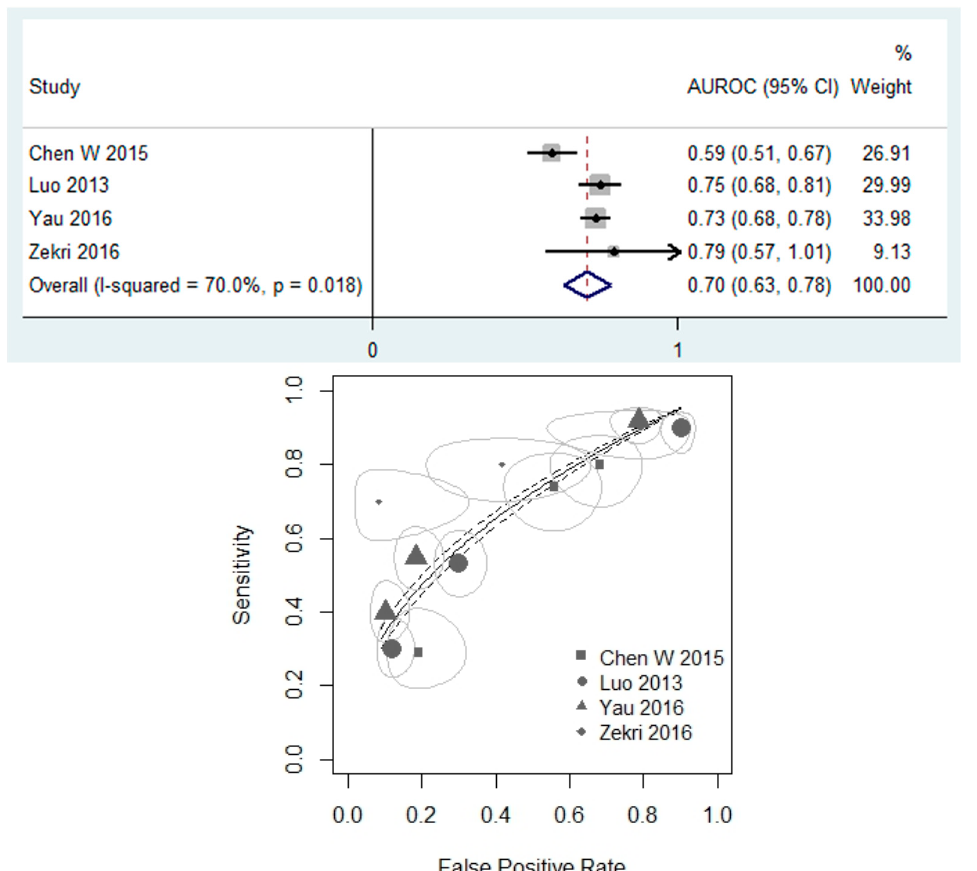
Figure 3. (Top) Forest plot for meta-analysis of AUROC using random effects analysis. (Bottom) Summary ROC curve. ROC curve and standard error are presented. The size of the points is representative of the weight of the individual studies.